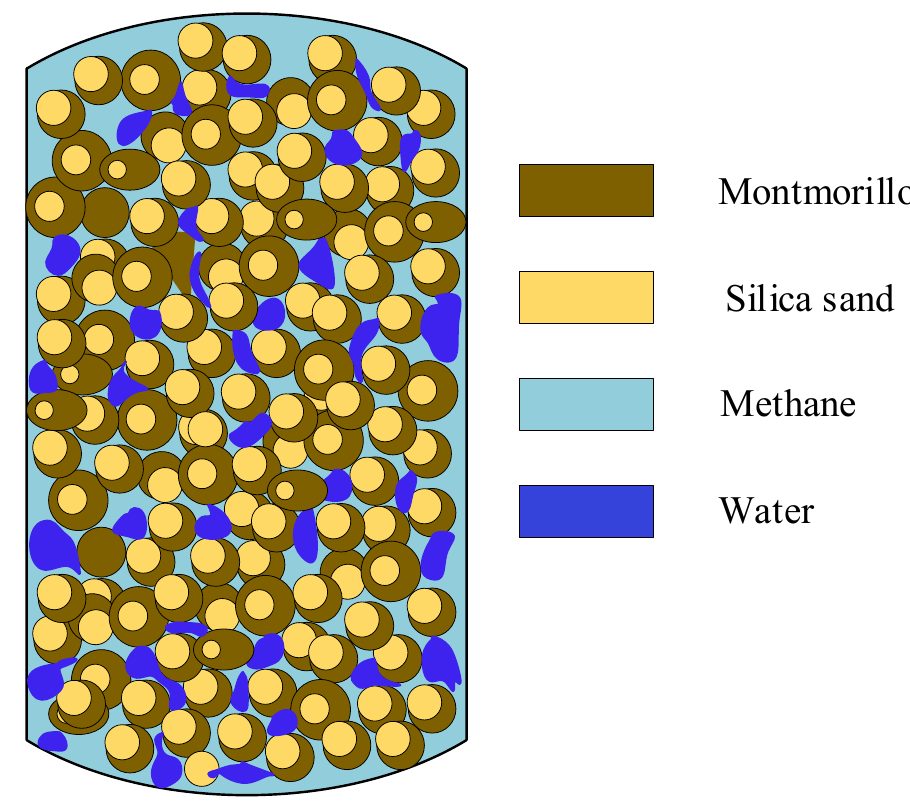
Figure 3. Schematic view of the distributions of different components in the reactor. Water conversion is defined as the mole percentage of water converted to